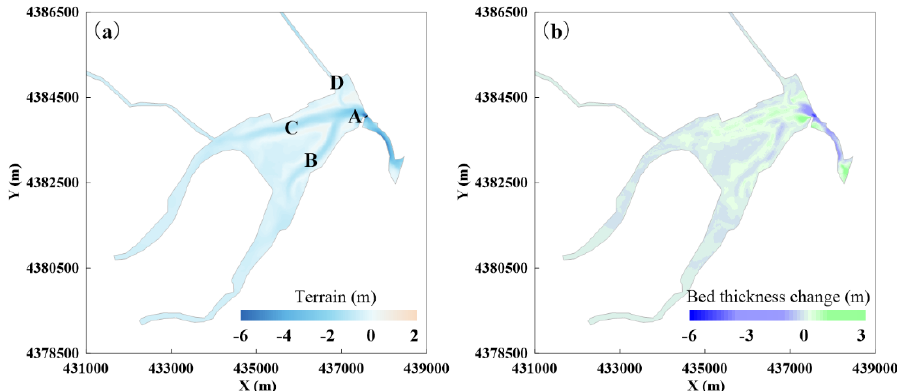
Figure 11. ( a ) Bathymetric map on 1 January 1990; ( b ) bed thickness change for the QL system from 1980 to 1989.